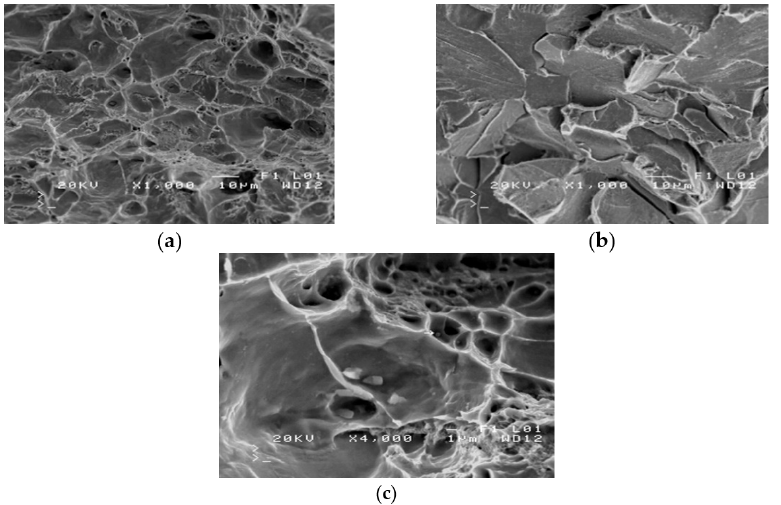
Figure 25. Scanning electron microscope (SEM) views (handy-size bulk carrier 30206 DWT): ( a ) the ductile structure of the fracture; ( b ) the brittle structure of the fracture; and ( c ) nonmetallic inclusions inside craters.